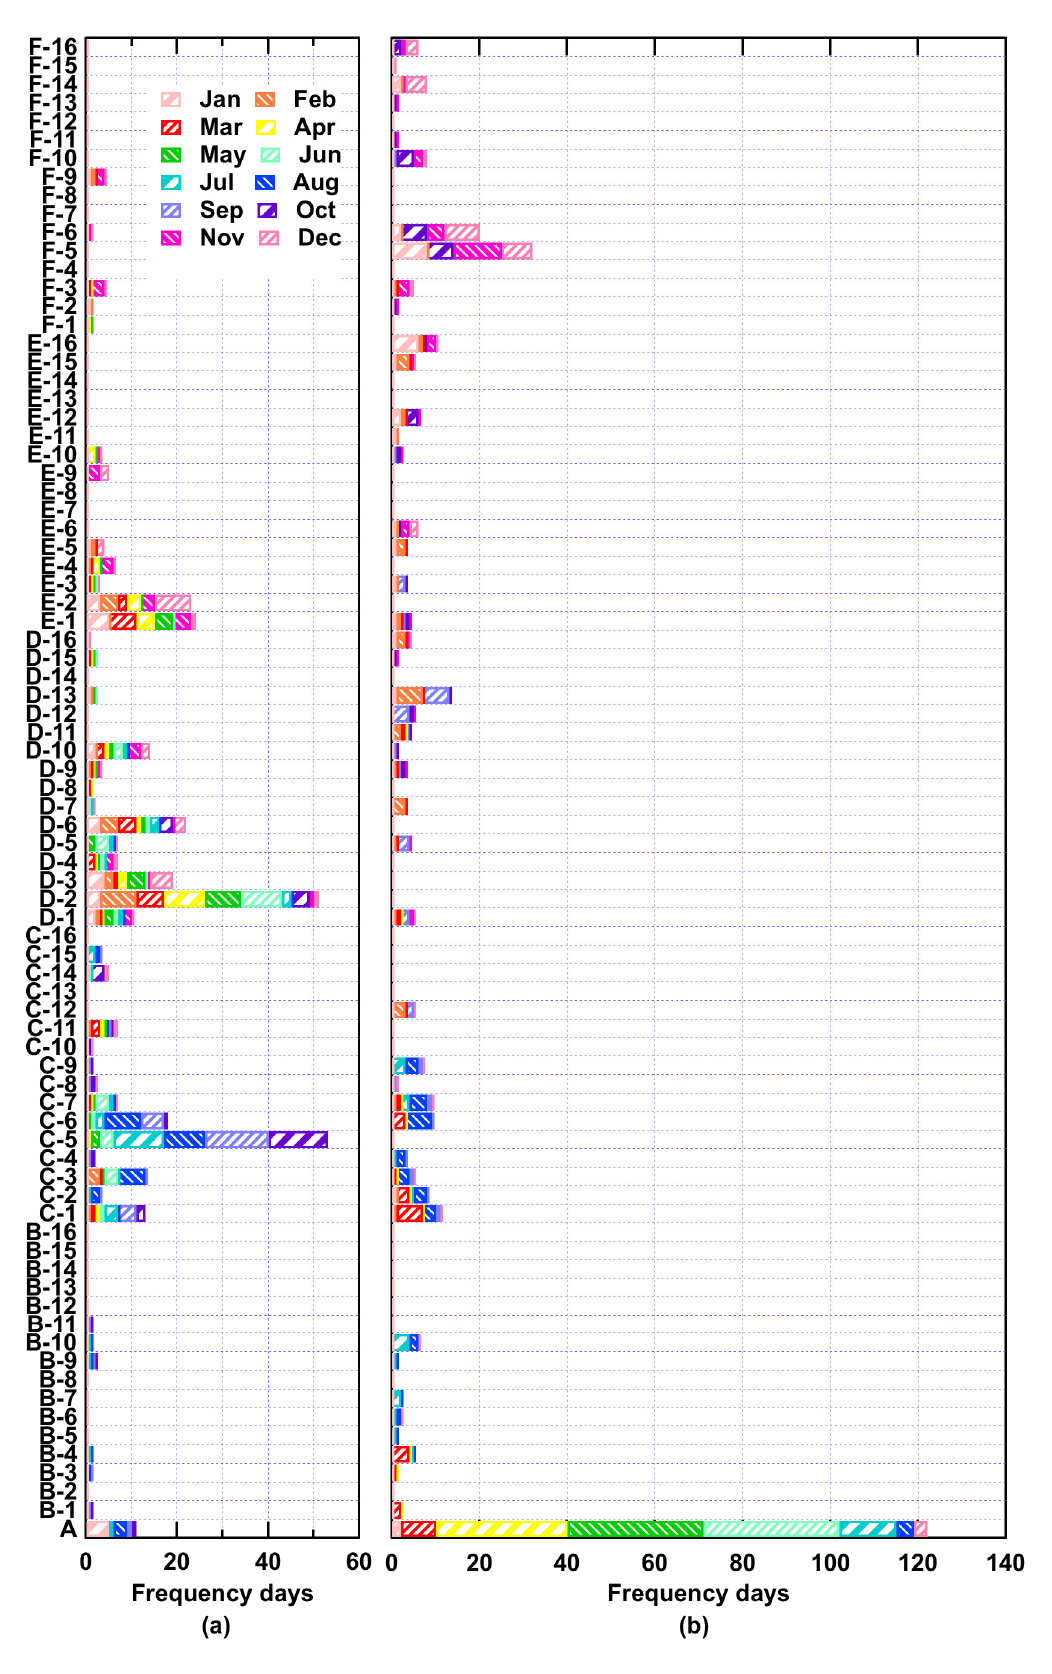
Figure 14. Cluster histograms labeled from a monthly perspective. ( a ) House A; ( b ) House